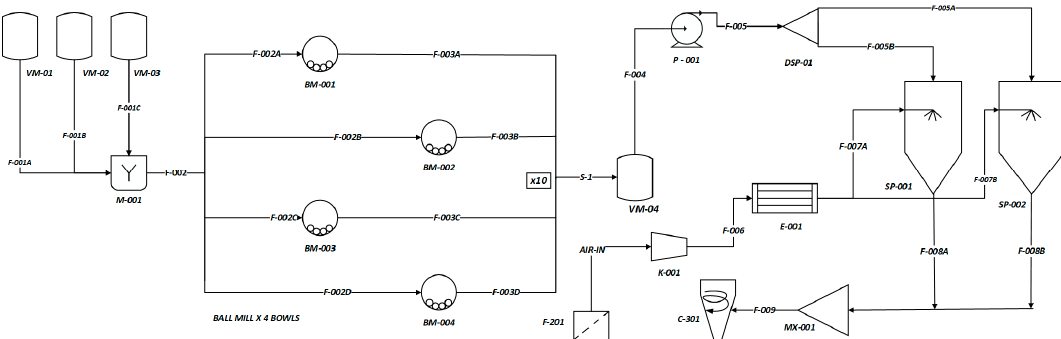
Figure 17. Process flow diagram nomenclature; VM-01 : IBU vessel, VM-02 : Mannitol vessel, VM-03 : Pharmacoat 603 vessel, VM-04 : Vessel container; BM-001, BM-002, BM-003, BM-004 : Mill bowl; DSP-01: F-SPLIT; P-001: Pump; F-201: Air Filter; K-001: Compressor; H-001: Heater unit; SP-001, SP-002 Spray Dryer Unit; M-001: Mixer, MX-001: Flow chamber, C-301: Cyclone.